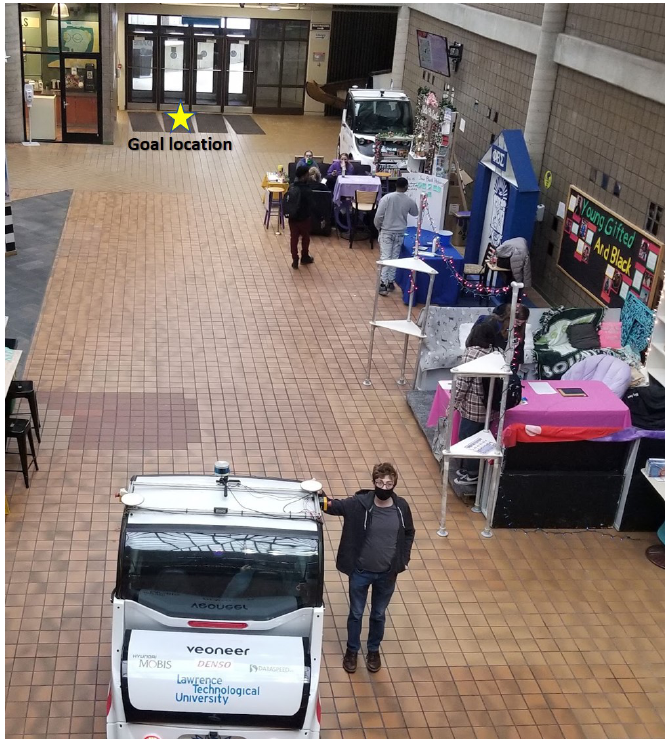
Figure 11. Author M. Kocherovsky poses with ACTor 1 before an experimental trial. The yellow star denotes the approximate target location. Picture taken by author CJ